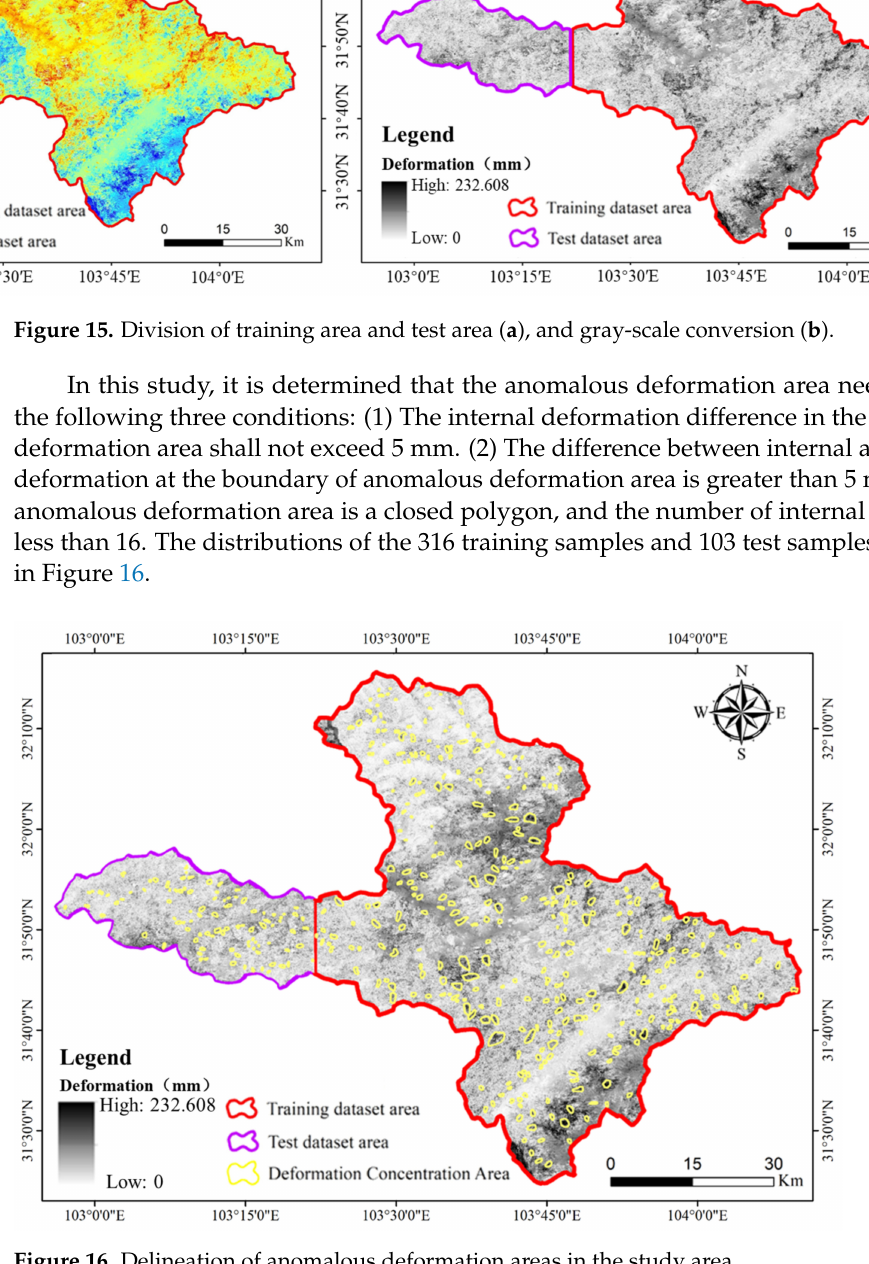
Figure 16. Delineation of anomalous deformation areas in the study